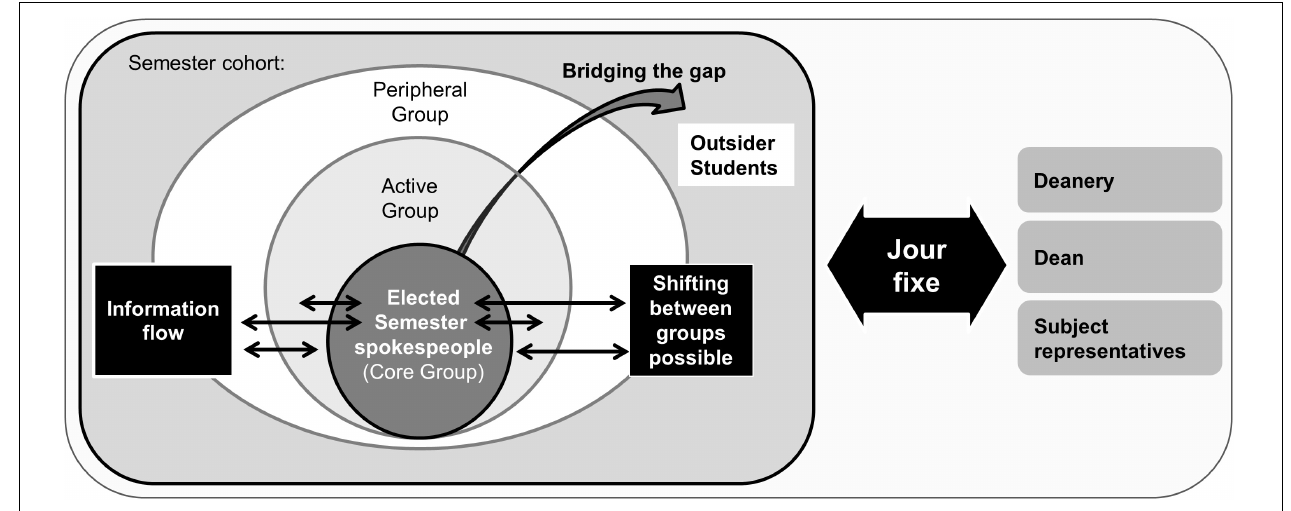
FIGURE 1 | CoP: Communication structure and group affiliation